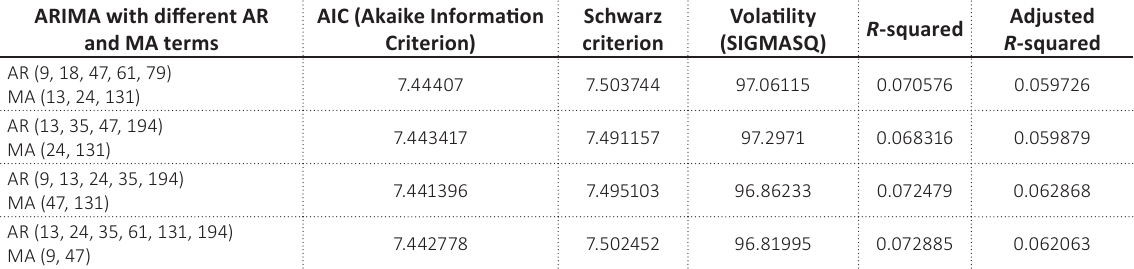
Table 2. Results of the best 4 adjusted ARIMA models for Sun Pharmaceutical Industries Ltd.